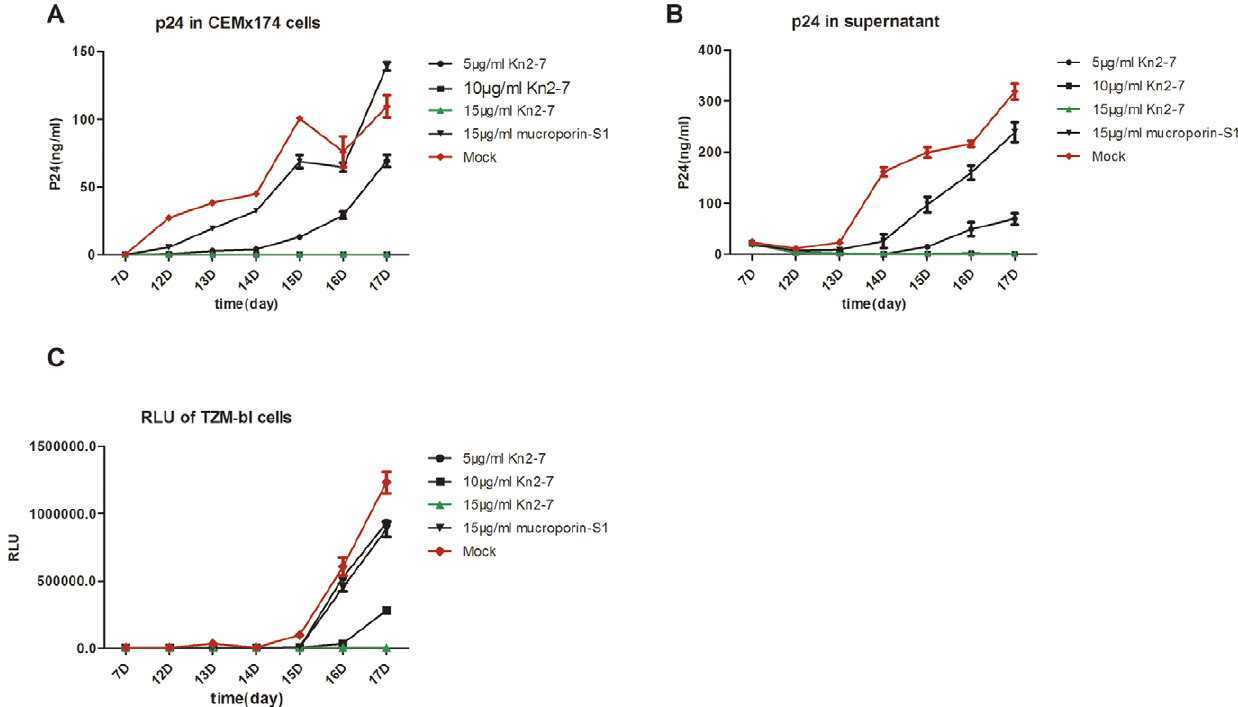
Figure 6. Antiviral activity of Kn2-7 against a replication-competent HIV-1 virus. Three dilutions of Kn2-7 or mucroporin-S1 were incubated with HIV-1 virus for 1 h at 37 u C, and then were added to CEM 6 174 cells in 12-well plates in duplicates for 17 days. Samples were collected at day 7, 12, 13, 14, 15, 16, and 17 after infection and p24 protein concentration of the cells and supernatants were detected by ELISA. The infectivity was measured by TZM-bl detection luciferase assay. (A) CEM 6 174 cells samples were measured for p24 protein by ELSIA. (B) CEM 6 174 supernatant samples were measured for p24 protein by ELSIA. (C) Samples were detected for infectivity by TZM-bl detection system.